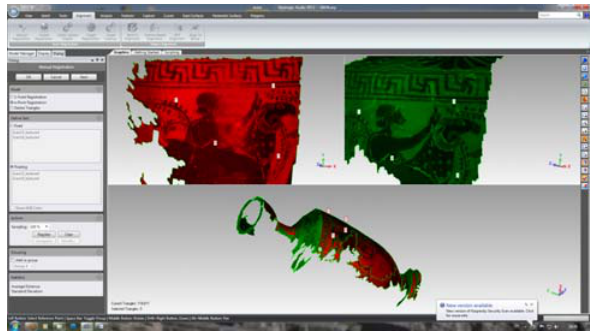
Fig. 4. Registration of two meshes using ICP algorithm procedure in Geomagic Studio software